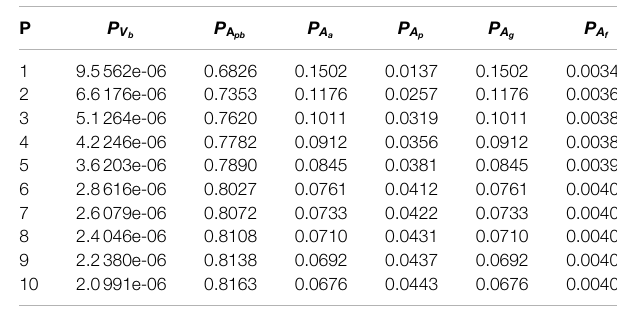
TABLE 5 | Weight parameter sets considered for the data from year